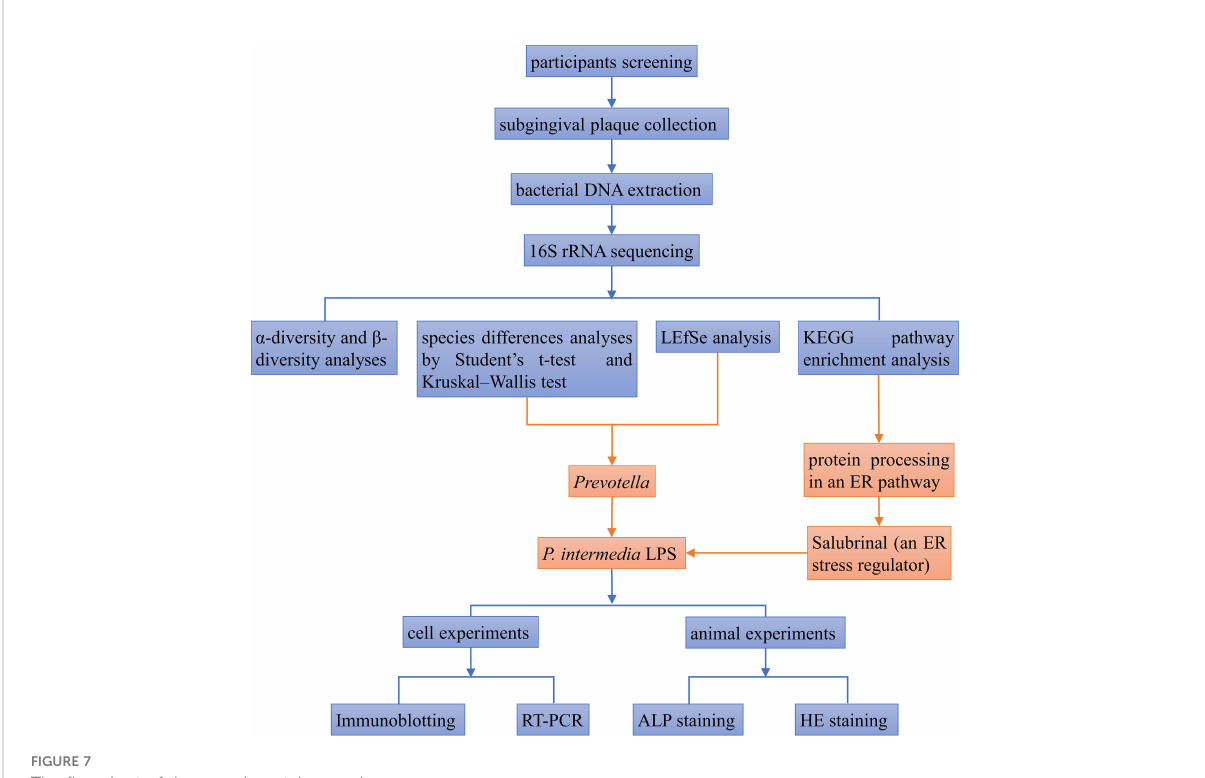
FIGURE 7 The fl owchart of the experimental